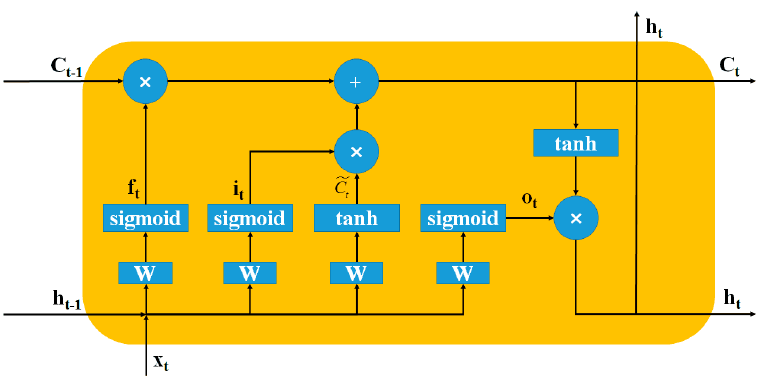
Figure 2. The structure of a single long short-term memory (LSTM) cell [37]. The LSTM cell can remember values over arbitrary time intervals and produce memories in